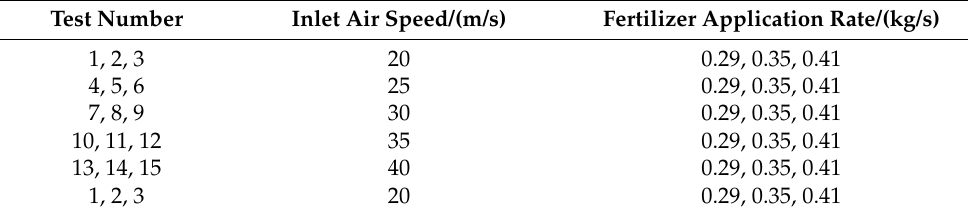
Table 5. Inlet wind speed and fertilization rate parameters.